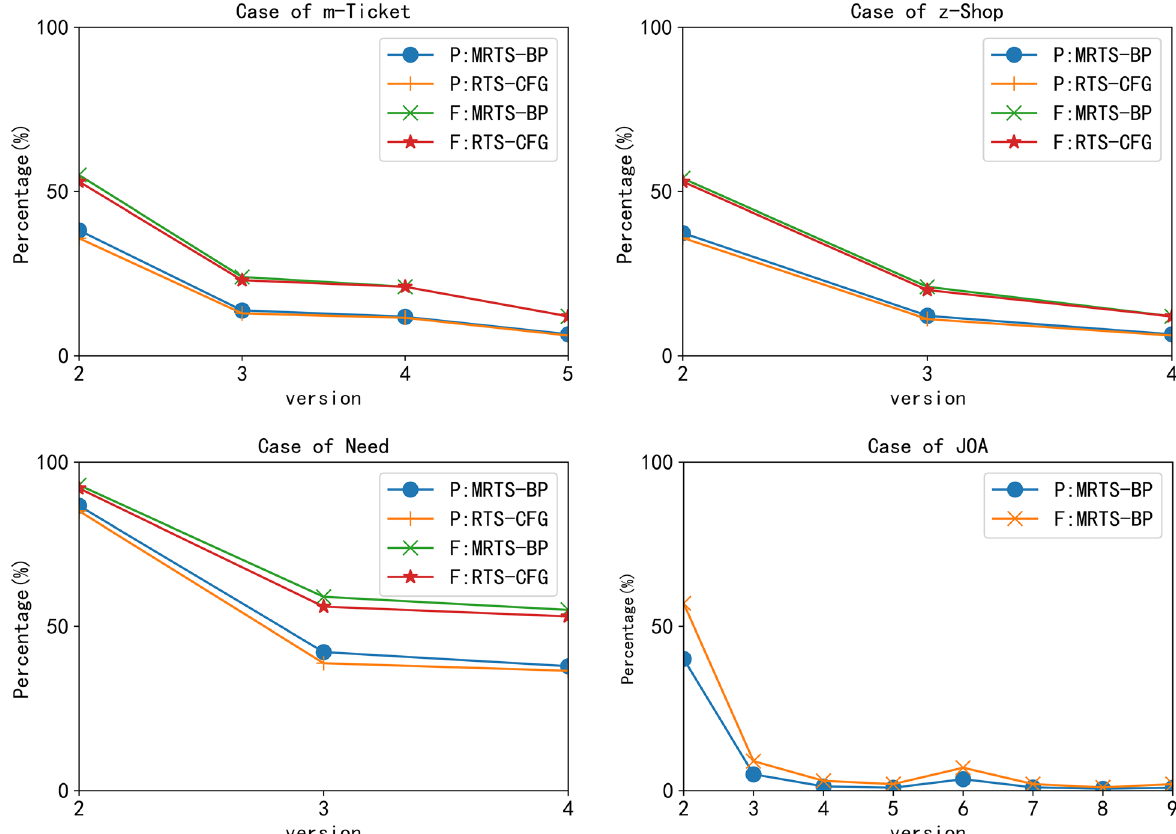
Fig. 8 The line charts of each case in Experiment